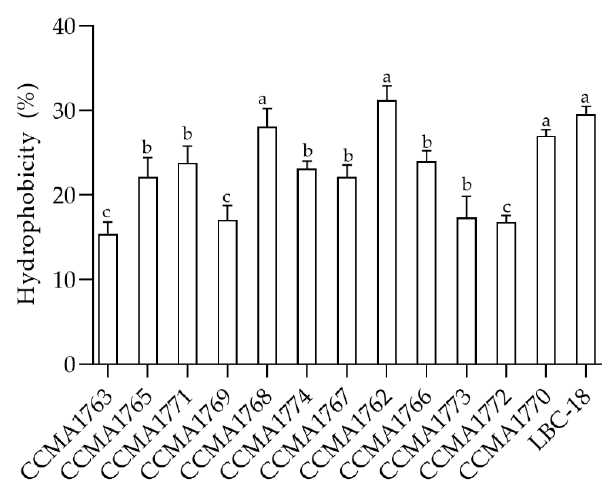
Figure 1. Percentage (%) of Hydrophobicity obtained for the different LAB isolates. Bar indicates SD. Bars followed by different letters differ significantly ( p < 0.05) by the Scott – Knott test.